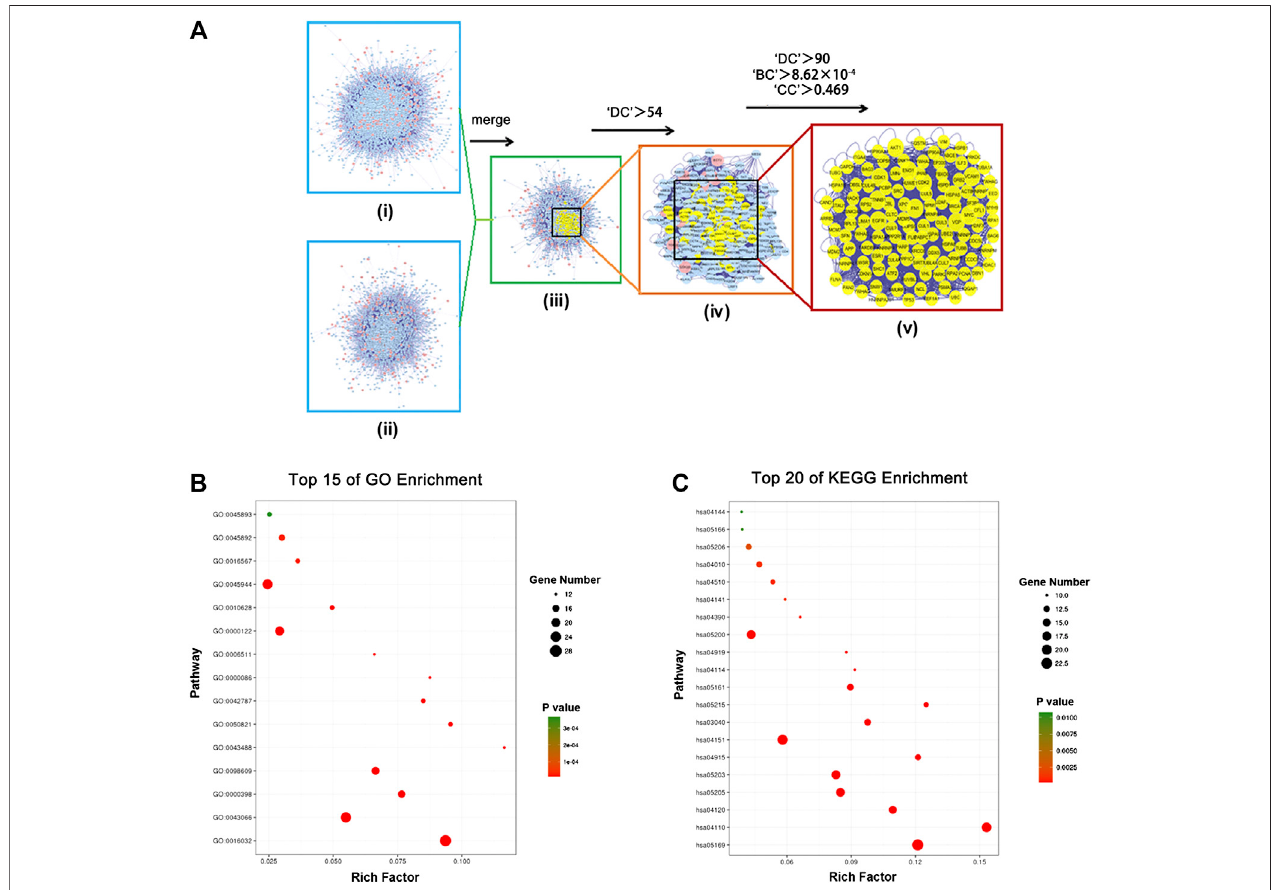
FIGURE 3 | In silico identi fi cation and enrichment analysis of candidate core targets for DSD against GC. (A) i) The interactive PPI network of DSD putative drug targets was made of 4,961 nodes and 110,021 edges. ii) The interactive PPI network of GC-related protein targets was composed of 2,882 nodes and 50,906 edges. iii) The interactive PPI network of DSD putative drug targets and known GC- related targets made of 1,762 nodes and 39,450 edges was shown. iv) PPI network of signi fi cant targets extracted from iii, in which 460 nodes and 17,748 edges were included. v) PPI network of candidate core targets extracted from iv, in which 123 nodes and 2,808 edges were included. (B) Candidate core targets were enriched in the representative biological processes by using DAVID v6.8 ( p -value < 0.05). (C) Candidate core targets were enriched in the representative signaling pathways by using DAVID v6.8 ( p -value < 0.05).